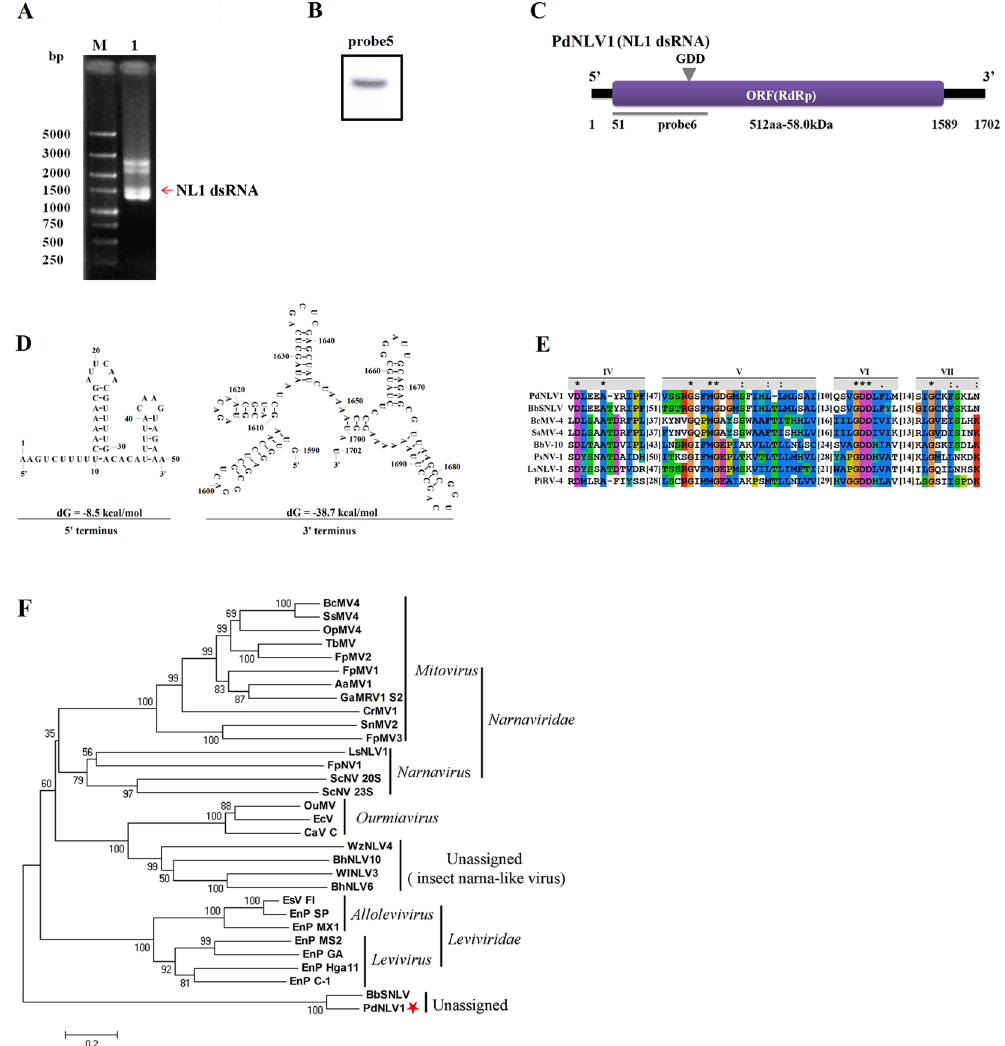
Figure 2. Molecular characterization and evolutionary analysis of PdNLV1. ( A ) Electrophoretic profile on a 1% agarose gel of dsRNA preparations extracted from P. digitatum isolate HS-RH2 after digestion with DNase I and S1 nuclease, and stained with ethidium bromide (lane 1). The dsRNA of PdNLV1 was indicated by red arrows. Lane M, DNA size marker (DS 5000, TaKaRa, Dalian, China). ( B ) Northern blot analysis of PdNLV1 dsRNA extracted from P. digitatum isolate HS-RH2 (Fig. S7). The position of the specific probe (probe 5) was shown in panel C. ( C ) Schematic representation of the genetic organization of PdNLV1. ( D ) Predicted secondary structure of the PdNLV1 5 ′ - and 3 ′ -UTRs with the lowest energy. ( E ) Comparison of the conserved motifs of RdRps encoded by PdNLV1 and other selected mycoviruses. Four conserved RdRp motifs corresponding to motifs IV, V, VI and VII were shown. The asterisks signified identical amino acid residues, colons signified highly conserved residues, and single dots signified less conserved but related residues. Numbers within the brackets indicated the number of aa not shown. ( F ) Phylogenetic analysis of PdNLV1 RdRp and other selected RdRps. Members of narnaviruses and Narna-like viruses in databases (Table S2) were selected, and the phylogenetic trees for RdRp sequences were constructed using the neighbor-joining method of MEGA version 6 software with bootstrapping analysis of 1000